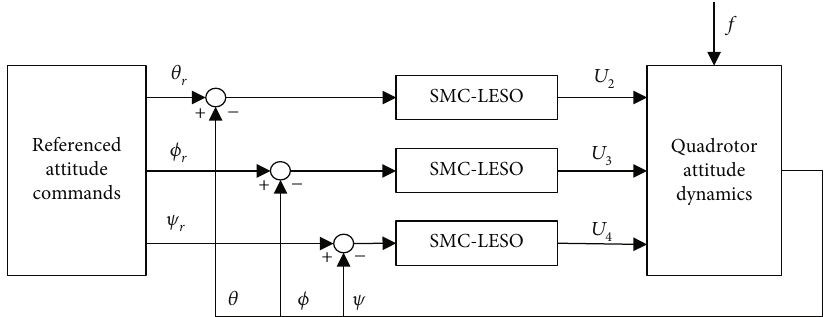
Figure 3: Block diagram of the designed control scheme.